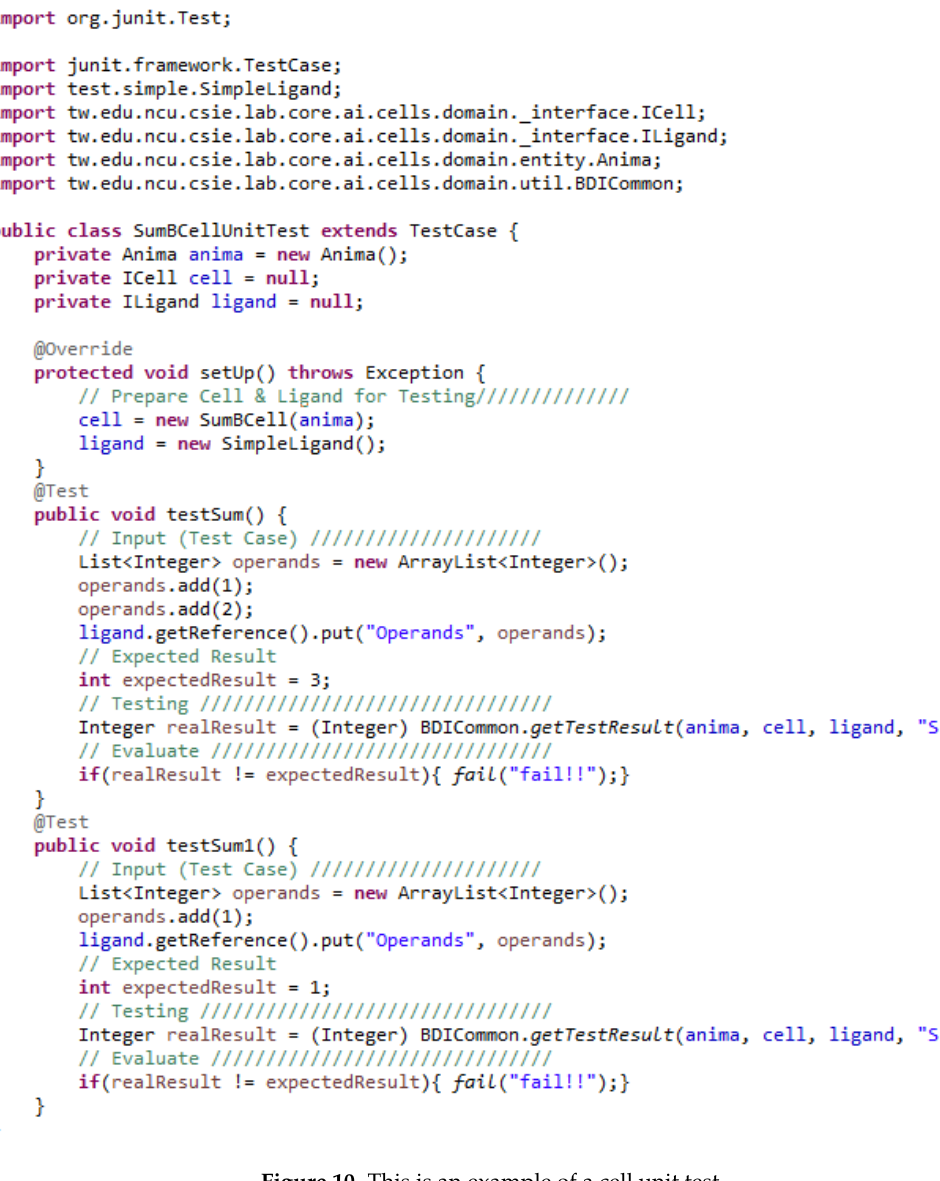
Figure 10. This is an example of a cell unit test.